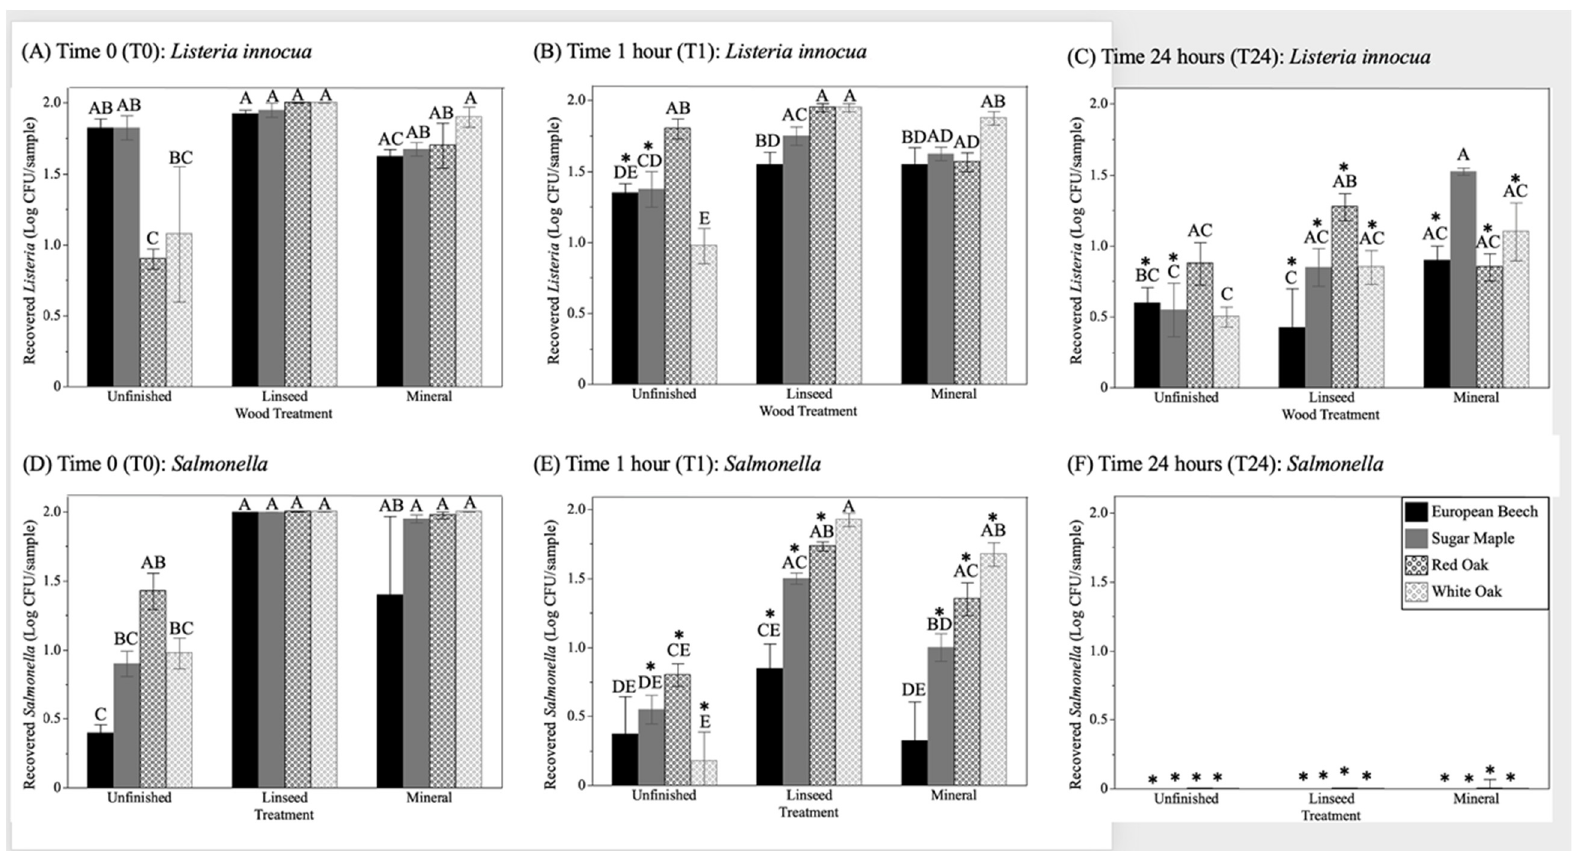
Figure 2. Recovery of Listeria innocua and Salmonella from various woods (European beech, sugar maple, red oak, and white oak) that was either left unfinished or coated with a single coat of linseed or mineral oil after selected time points ( A , D ) T0 = immediate collection; ( B , E ) T1 = collection at one hour; ( C , F ) T24 = collection at 24 h. Different letters indicate statistically significant differences at alpha = 0.05 within panel group. Asterisk (*) indicates a significant reduction in recovered bacteria from T0 within the same wood species and surface treatment. n = 4 for each bar.